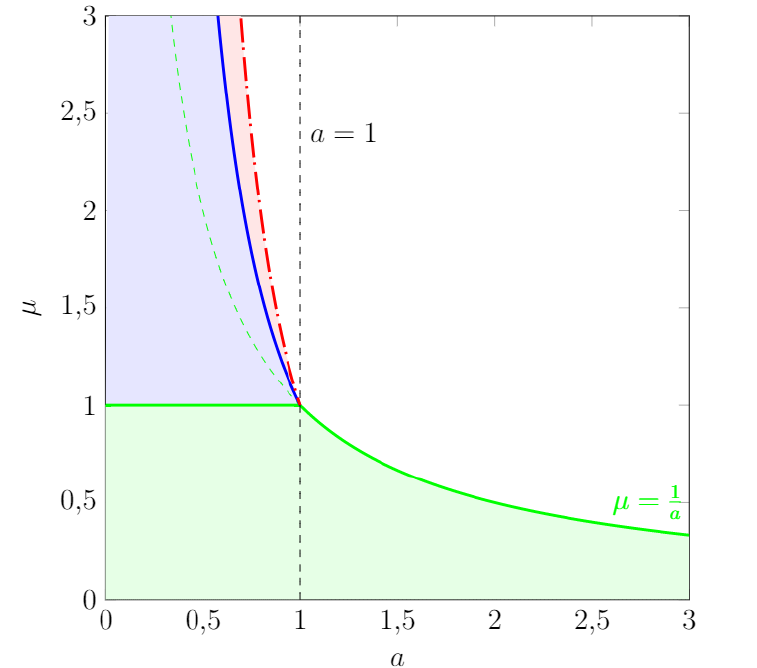
iid ∼ N ( 0, a ) . Green region: fully param- Figure 1: Model phase diagram when ξ i agnetic phase, where the Parisi overlap distribution is a Dirac delta centered at 0 as well as the Mattis magnetization. White region: ferromagnetic, replica symmetric phase. Here, the Parisi overlap distribution is still a Dirac located according to (17) and (18). The distribution of the Mattis magnetization is instead a sum of two deltas centered at ¯ x and − ¯ x with 1 / 2 coefficients, namely the solutions of (18). The model therefore turns out to be replica symmetric in the green and white areas. The blue region is delimited by µ = 1 and the blue curve drawn (here only qualitatively) by (19), which is above the green dashed hyperbola µ = 1 / a . In this region the model is in a replica symmetry breaking phase, i.e. the Parisi distribution is no longer con- centrated at a single point and ¯ x solves the more general variational principle (10). With reference to Proposition 5, the dash-dotted red line AT ( µ , a ) = 1, here drawn qualitatively, must contain the entire RSB phase, hence it must lie above (or at most touch) the blue curve. The analogy with the SK model (see Remark 6 below) would suggest the presence of a mixed phase in the red region where ¯ x (cid:54) = 0 and the overlap